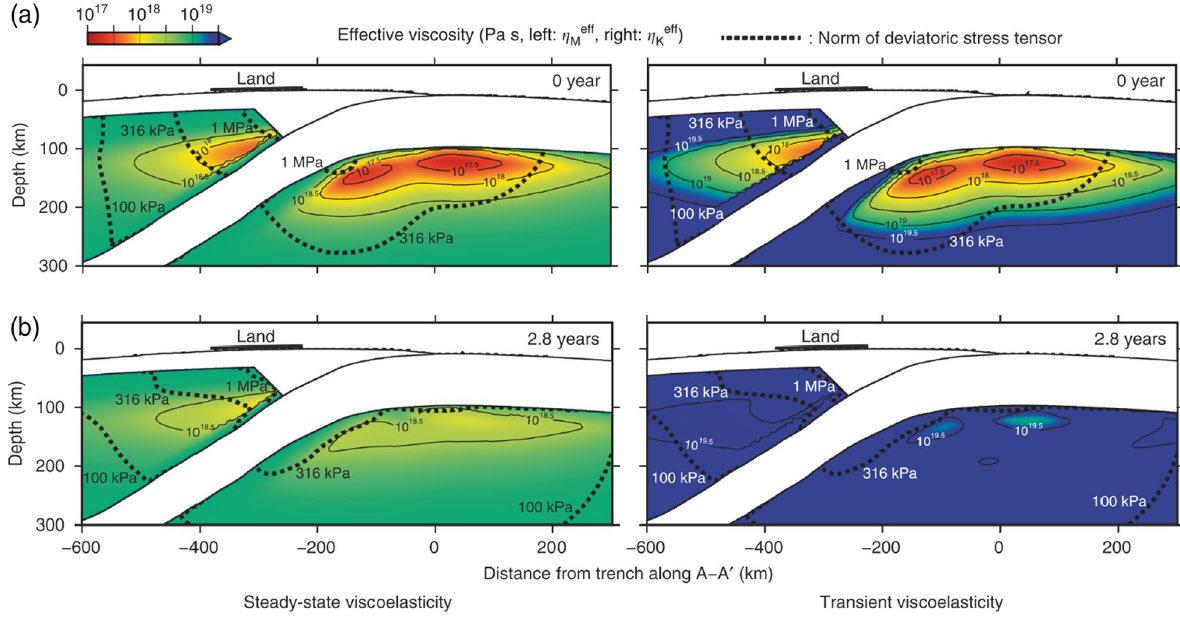
Fig. 13 The effective viscosity of steady-state (left) and transient creep (right) estimated by Agata et al. (2019). a 0 year, b 2.8 years after the earthquake. The profile is along the Miyagi-Yamagata